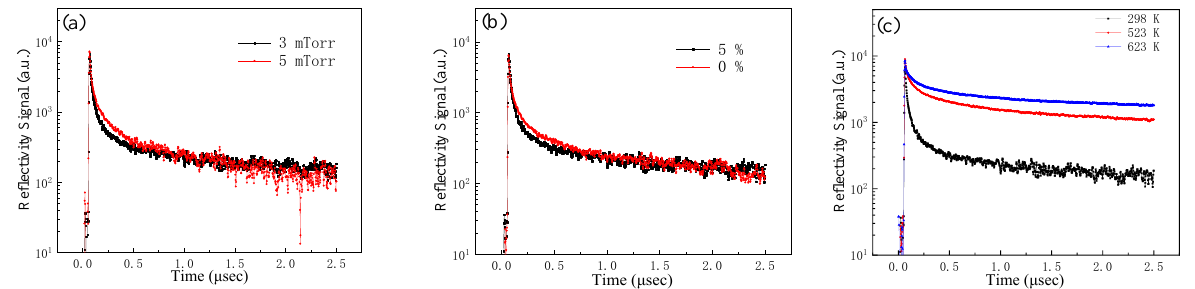
Figure 6. The photoelectric response curves of the ZATO films: ( a ) at different pressure (at 5% oxygen content and unannealed), ( b ) at different oxygen/argon ratios (at 3 mTorr and unannealed) and ( c ) at different annealing temperatures (at 3 mTorr and 5% oxygen/argon ratio).